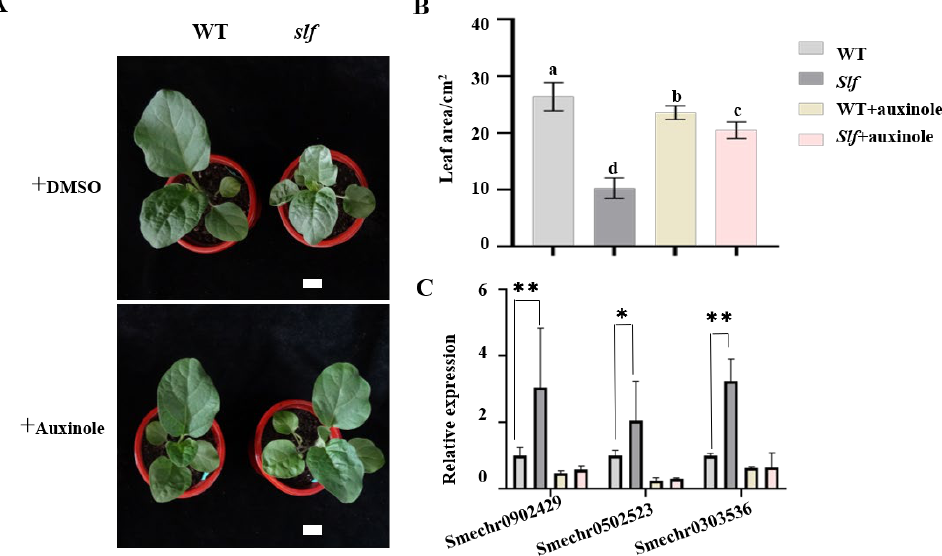
Figure 7. Effect of auxinole on leaf growth. ( A ) Leaf size under treatment with 10 µm/L DMSO or 20 µm/L auxinole. Bar = 1 cm. ( B ) Analysis of the leaf area 20 days after auxinole treatment. Values are the mean ± SE of three biological replicates. Different lowercase letters indicate significant dif- ferences ( p < 0.05) among treatments for each column or parameter. ( C ) Expression levels of some auxin response genes treated with auxinole. The asterisks show significant differences ( t-test ; *, p < 0.05; **, p < 0.01) between the plants treated with control and auxinole.